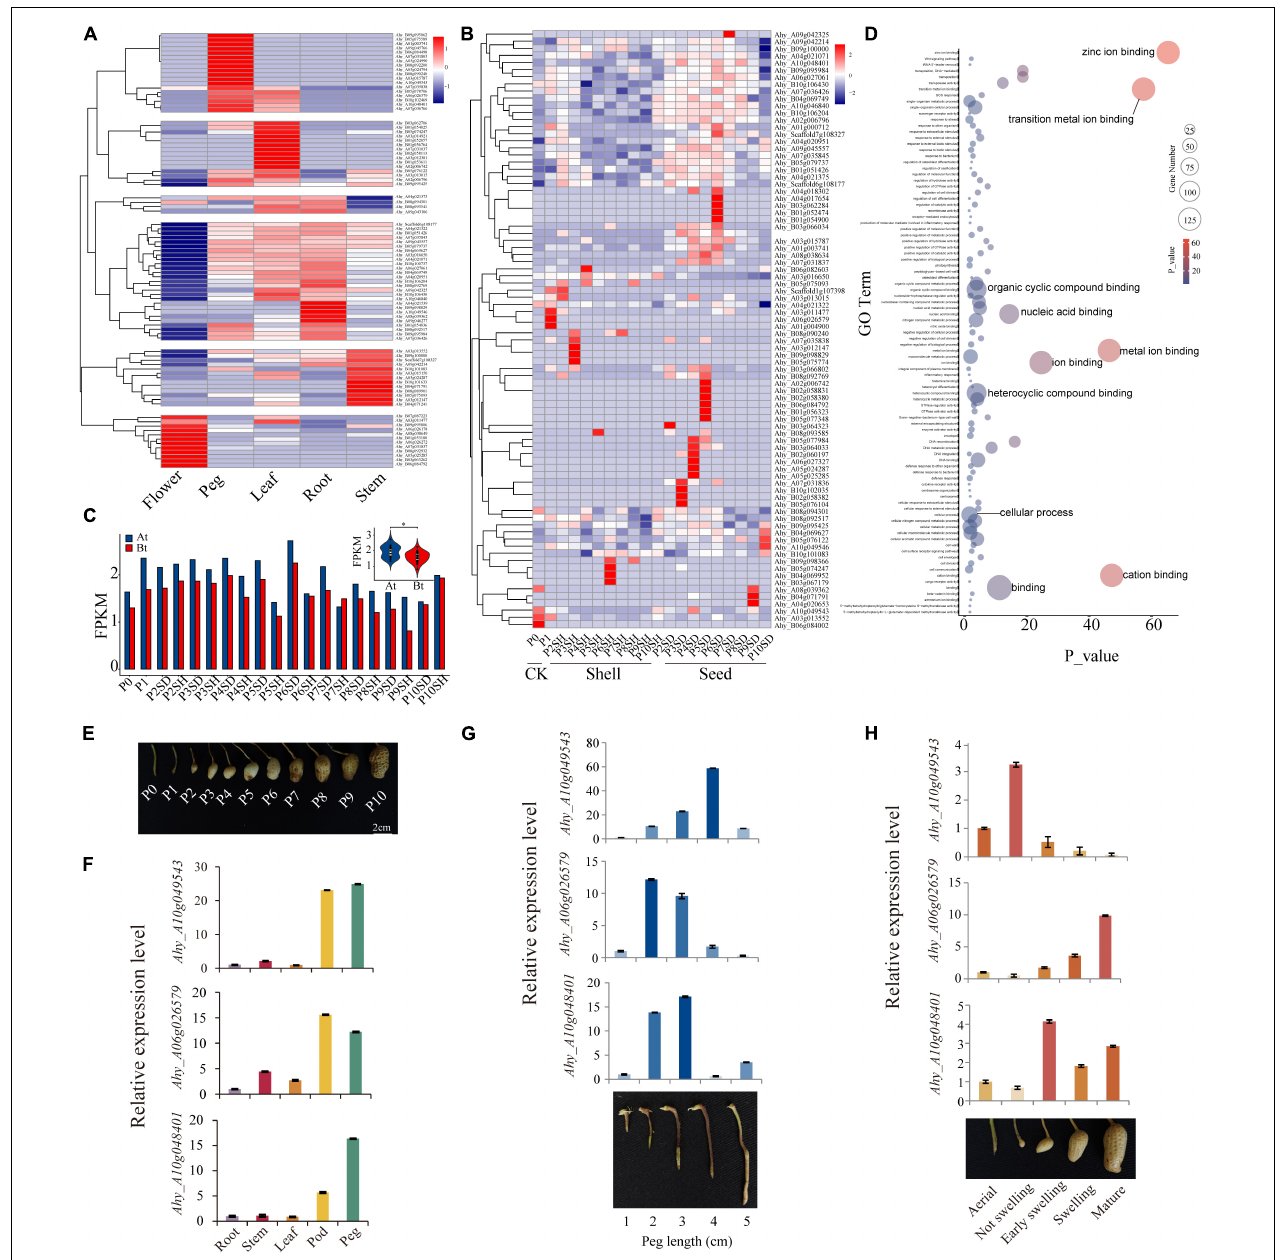
FIGURE 4 | Expression patterns of the peanut AhFAR1 gene family. (A) Clustering of expression profiles of AhFAR1 genes in different tissues, such as flower, peg, leaf, root, and stem. (B) Clustering of expression profiles of AhFAR1 genes in shell and seed at 11 development stages. (C) Comparison of the AhFAR1 expression levels between At and Bt. (D) GO term enrichment analysis of the AhFAR1 genes. (E) Eleven different developmental stages of peanut pods. (F–H) Relative expression level analyses of three candidate AhFAR1 genes in representative tissues, different length of pegs, and development stages of pod. *represents t -test of P <